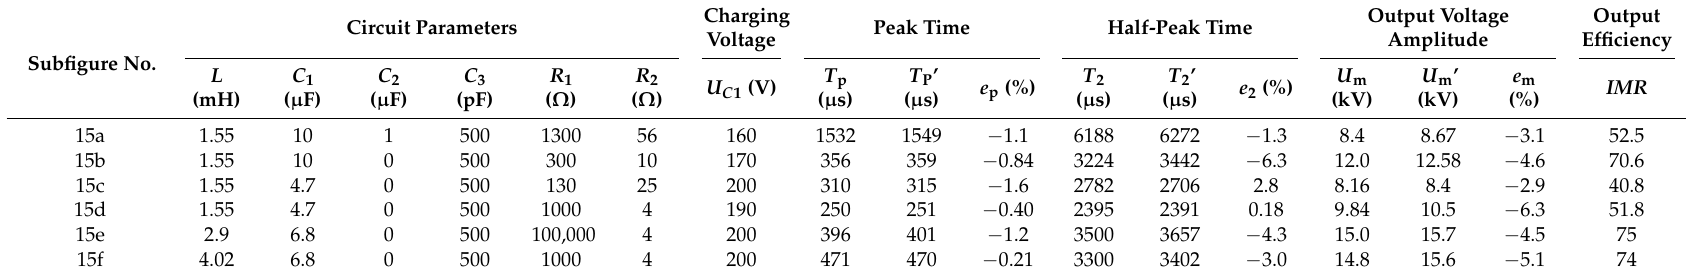
Table 3. Comparisons of the actual waveform parameters and the numerical results under different circuit parameters.